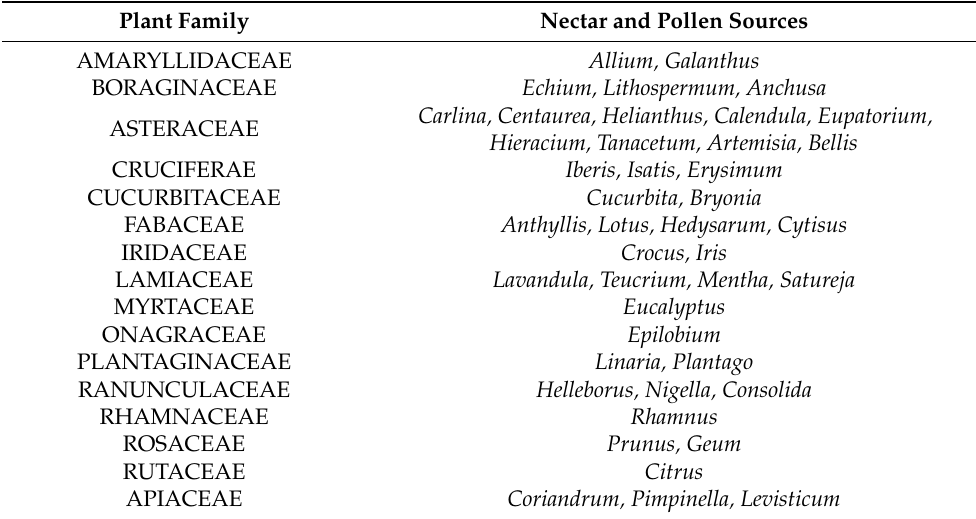
Table 3. Some examples of plant taxon (family, genus) of cultivated/non-native medicinal plants in Europe, in relation to bee foraging sources (nectar, pollen). Plant data from Wichtl [77], bee preferences for pollen and nectar from MLR, [73], MAA,